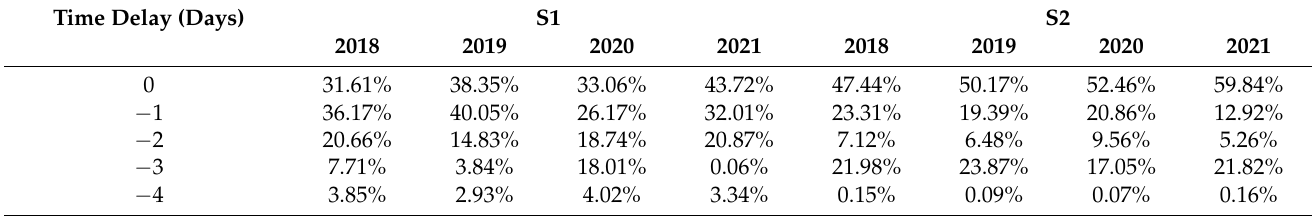
Table 5. Percentage of data acquired within a given time lag (dt) from the computed